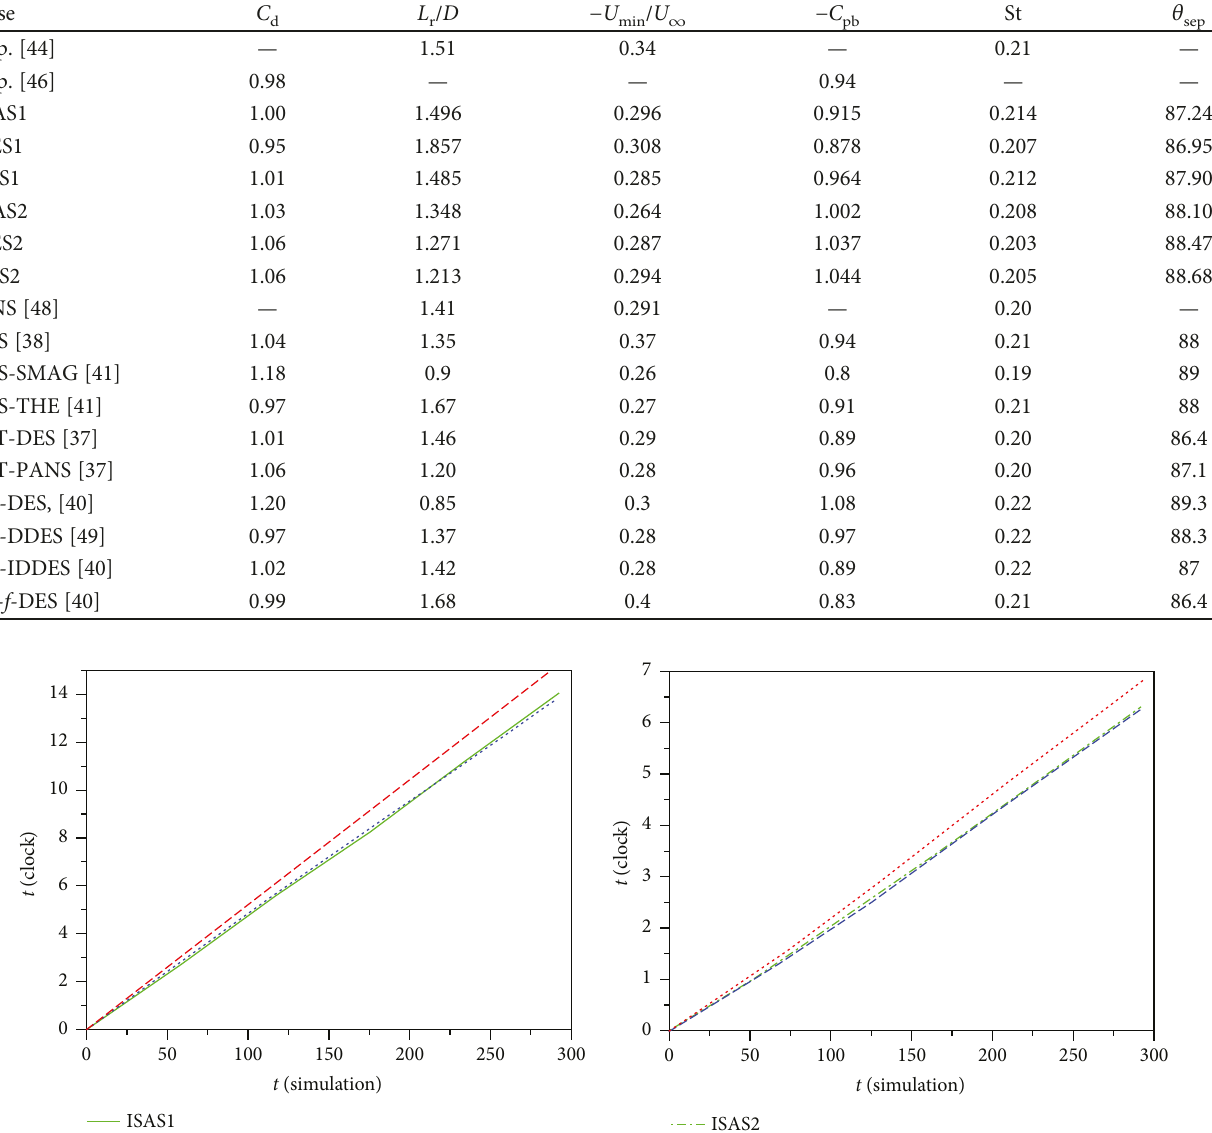
Table 1: Summary of the statistical fl ow quantities for the fl ow over a cylinder fl ow at Re =3900.